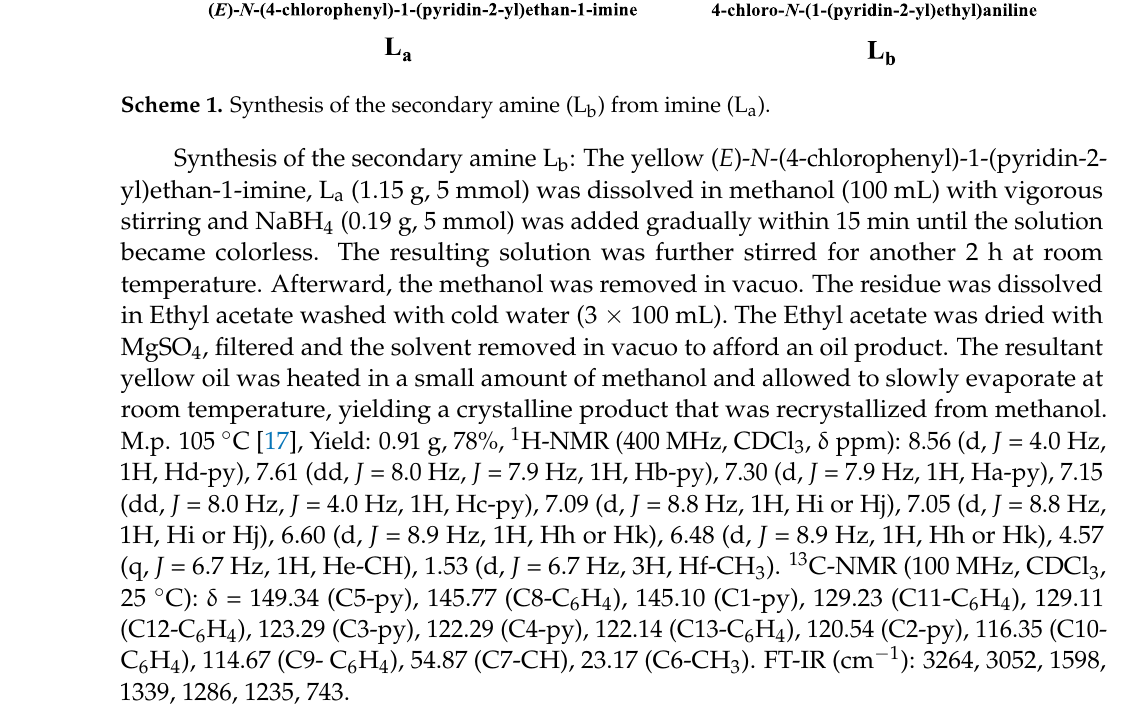
Table 2. Crystal data and structure refinement for L b .